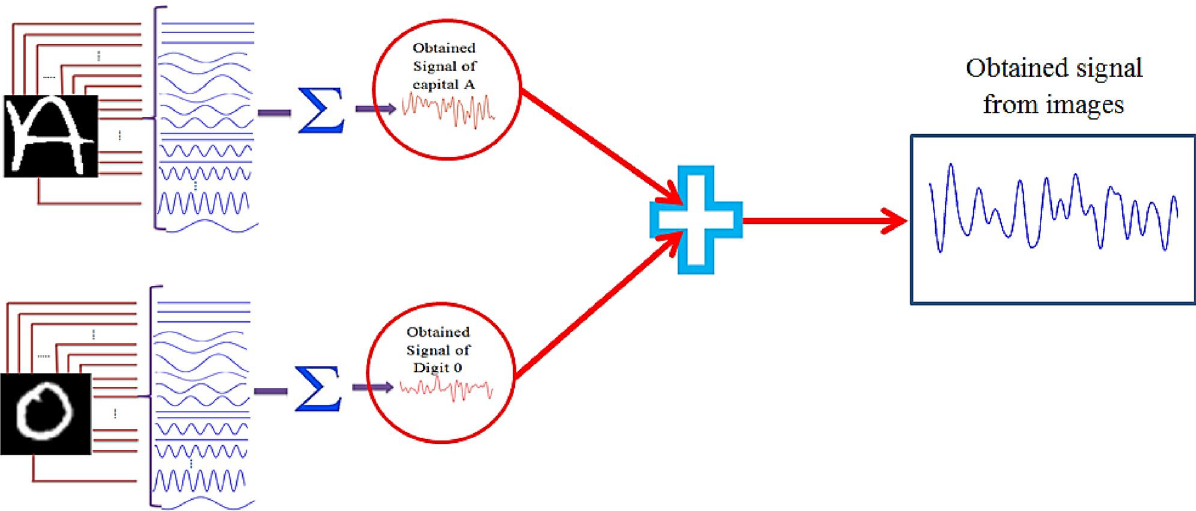
Figure 7. Combination of digit and letter to create the intertwined pattern of digit “0” and letter “A”. The informative signals of patterns are added to generate the new pattern that is an intertwined form of input